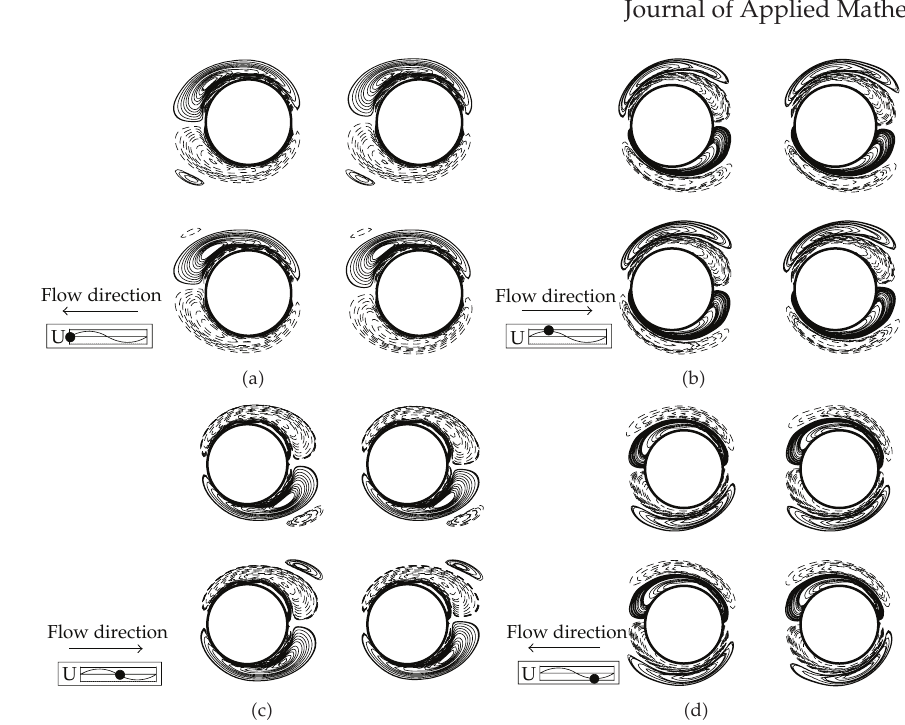
Figure 7: Snapshots of vorticity contours in the oscillatory flow interacting with four cylinders during a cycle at KC (cid:8) 2 and Re (cid:8)